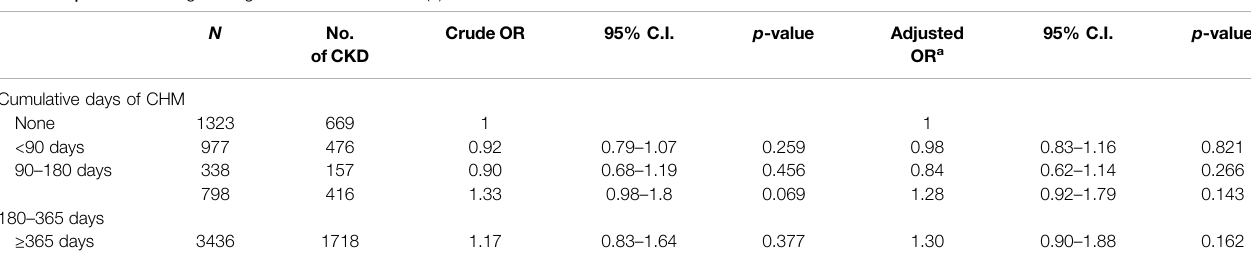
TABLE 4 | Conditional logistic regression of risk of CKD